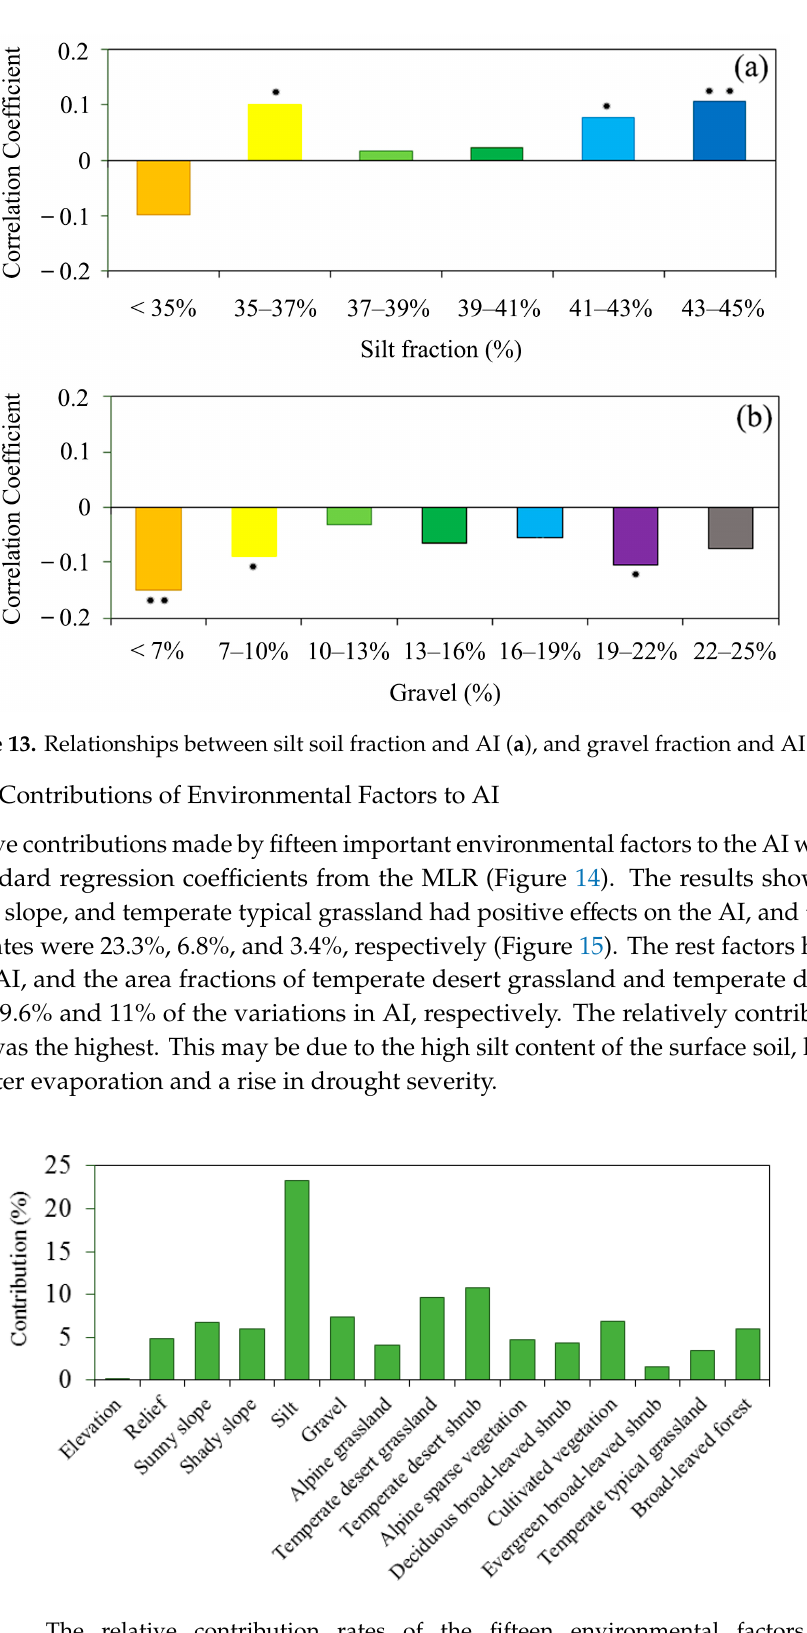
Figure 14. The relative contribution rates of the fifteen environmental factors to the vegetation vulnerability.